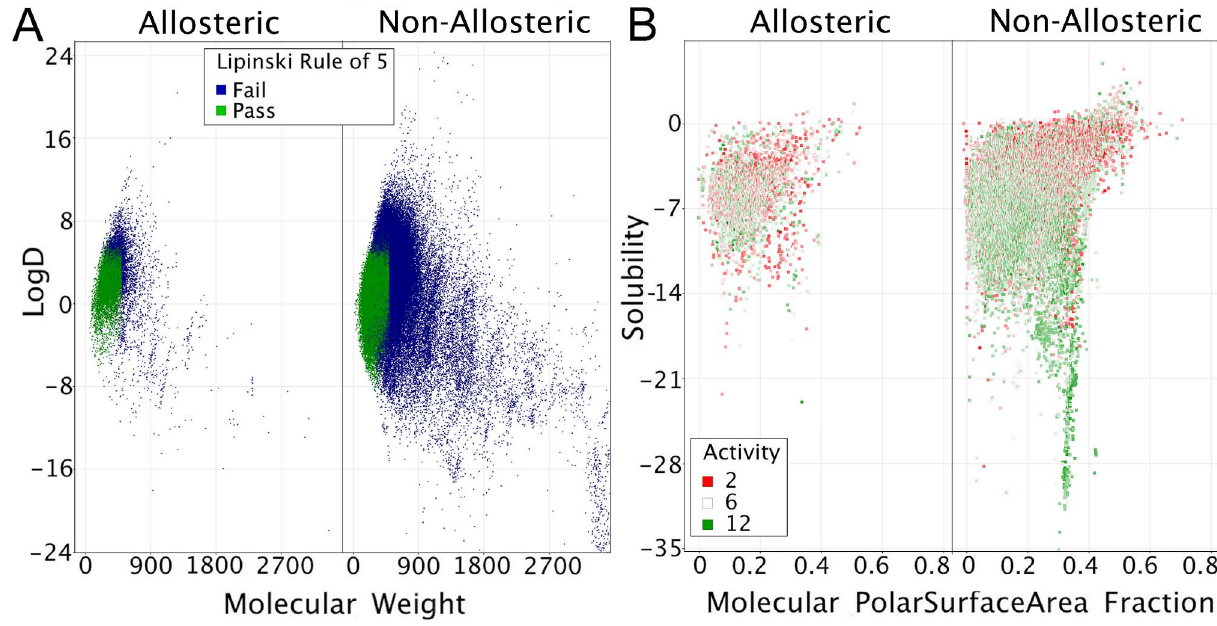
Figure 4. (A) Scatter plots showing the molecular weight (x), LogD (y) and adherence to the rule of 5 (color) of allosteric and non- allosteric compounds. The allosteric compounds represented a subset of the non-allosteric ligands; this image was conserved among most different target classes. (B) Scatter plots showing the molecular polar surface area fraction (x), solubility (y) and activity (color; pKi, pKd, pIC 50 , pEC 50 ,). The area of high activity was observed to be narrower in the allosteric set versus than non-allosteric set. The non-allosteric compounds could display high affinity along a broader range of both properties.